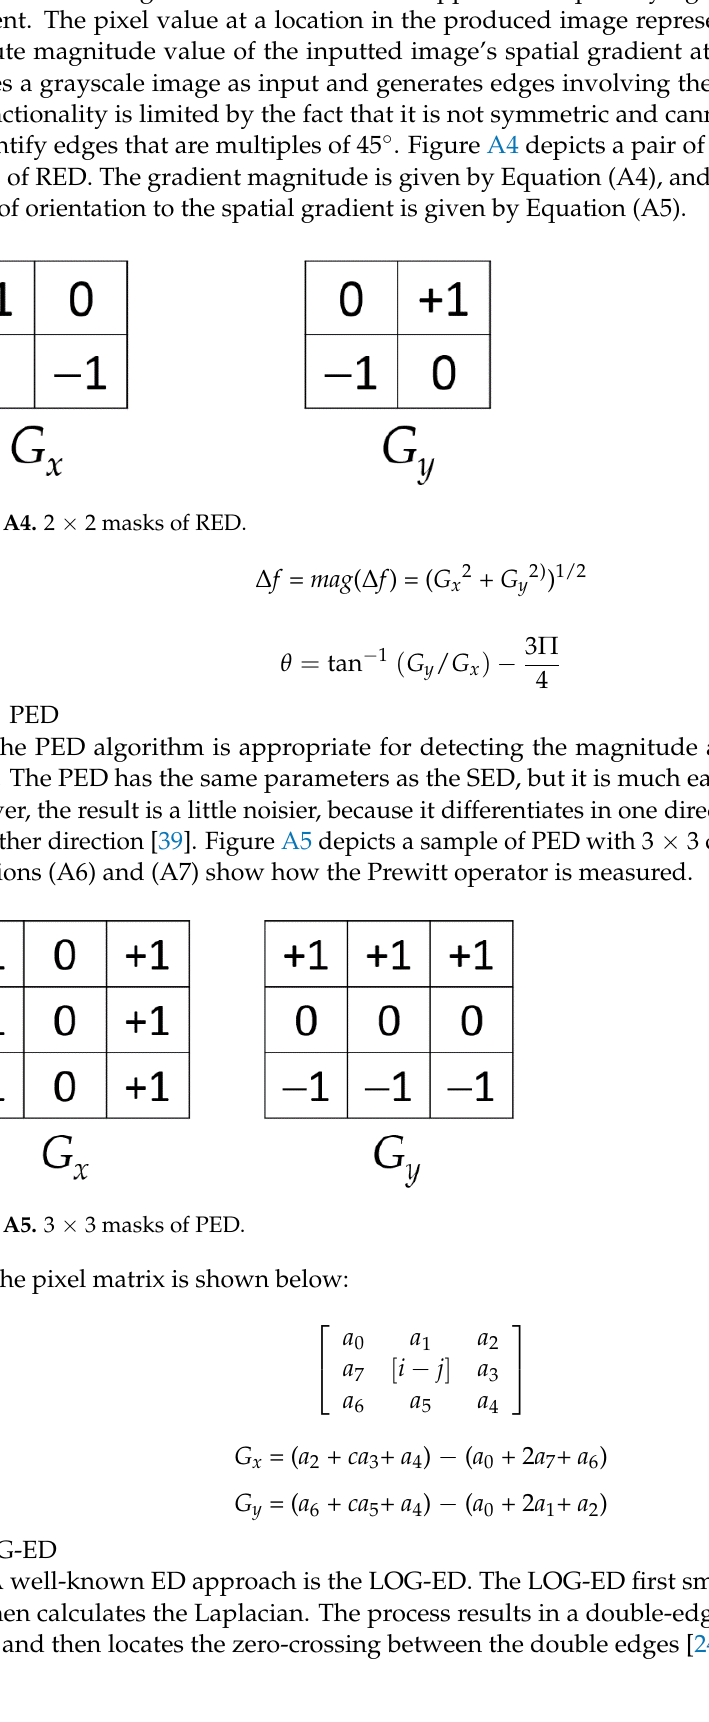
Figure A3. 3  3 masks of SED.